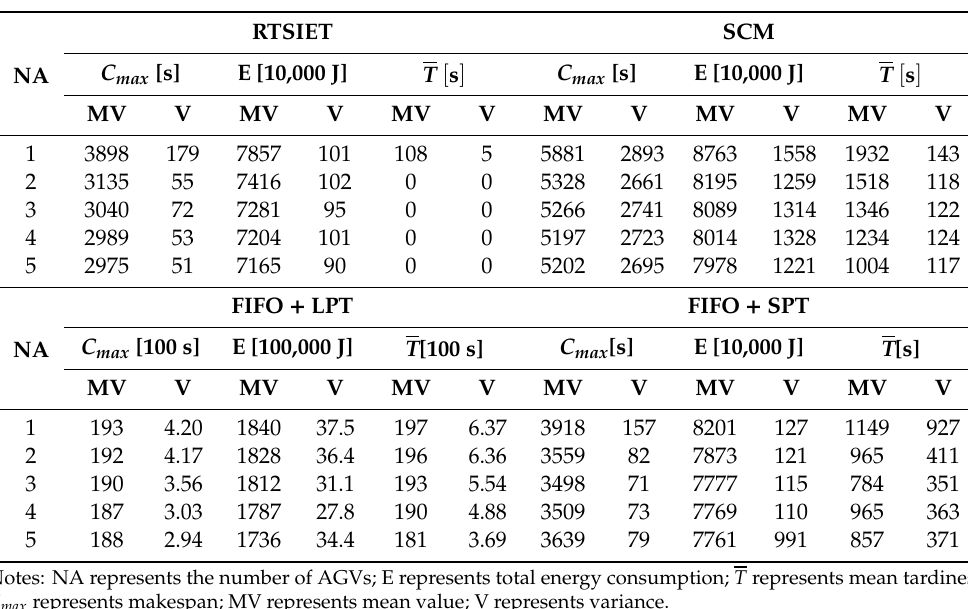
Table 6. Results comparison with the real-time scheduling algorithm based on the information entropy theory (RTSIET), self-adaptive collaboration method (SCM), first in first out (FIFO) + longest processing time (LPT), and FIFO + the shortest processing time (SPT).